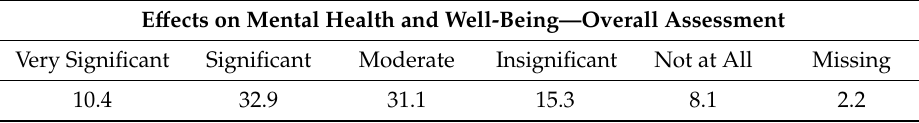
Table 5. Overall assessment of the e ff ects on mental health and well-being.